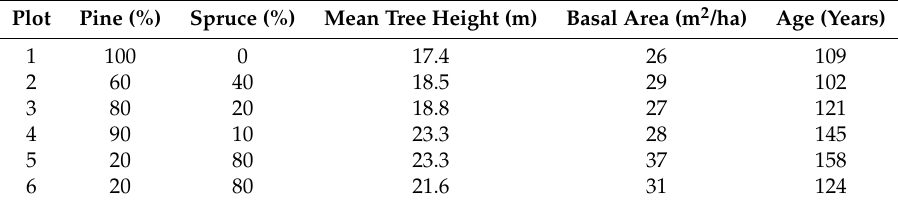
Table 1. Stand average values for the plots used in the stem profile evaluation. The mean tree height was basal area weighted.